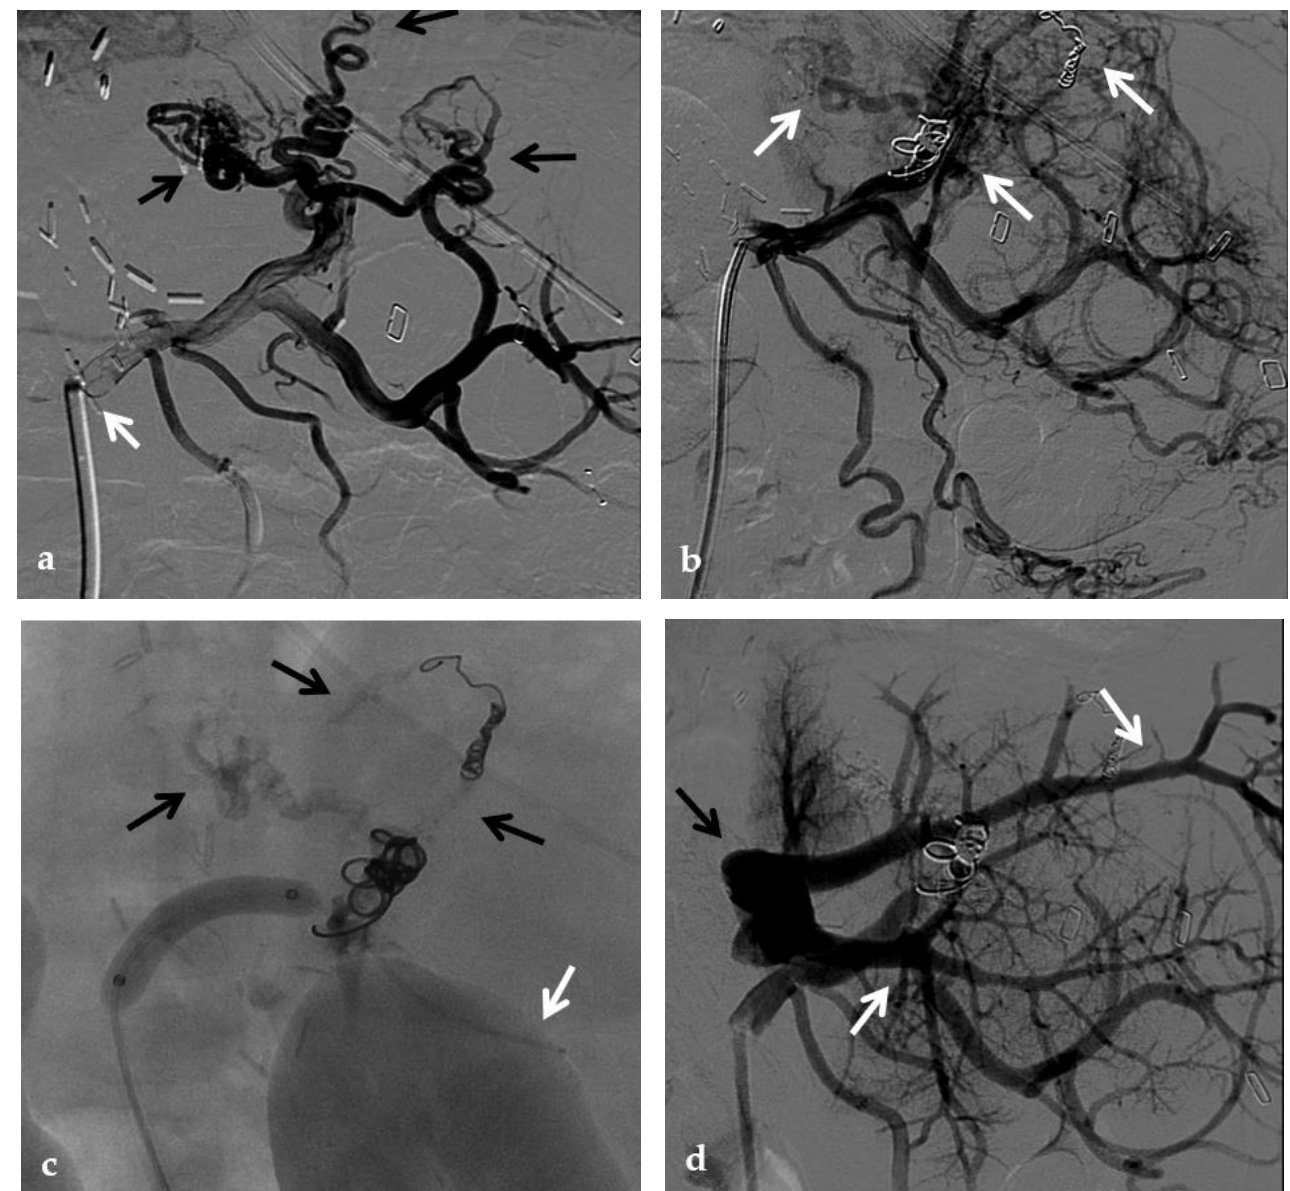
Figure 11. Anteroposterior view of a percutaneous transmesenteric portography imaging series of an acute complete portal vein thrombosis occurred early after pediatric split-liver transplantation in a 1-year-old female with biliary atresia. ( a ) Superior mesenteric portography performed through a surgically-placed transmesenteric sheath (white arrow) shows total occlusion of the main portal vein and its intrahepatic branches, with opacification of several portosystemic varices (black arrows). ( b ) Superior mesenteric portography shows effective embolization of the portosystemic shunts to reduce the flow-steal phenomenon. A mixture of N-butyl cyanoacrylate and iodized oil and metallic microcoils (arrows) were used. ( c ) Portography image shows angioplasty with a 5-mm non-compliant balloon catheter performed on a stiff guidewire advanced through the common portal vein (white arrow). Note the spontaneous remaining opacification caused by the mixture of N-butyl cyanoacrylate and iodized oil (black arrows). ( d ) Final superior mesenteric portography shows restored opacification of the portal vein anastomosis, the umbilical recess of the portal vein (black arrow) and the intrahepatic segment 2 and segment 3 branches (white arrows), with no contrast filling of the portosystemic shunts.